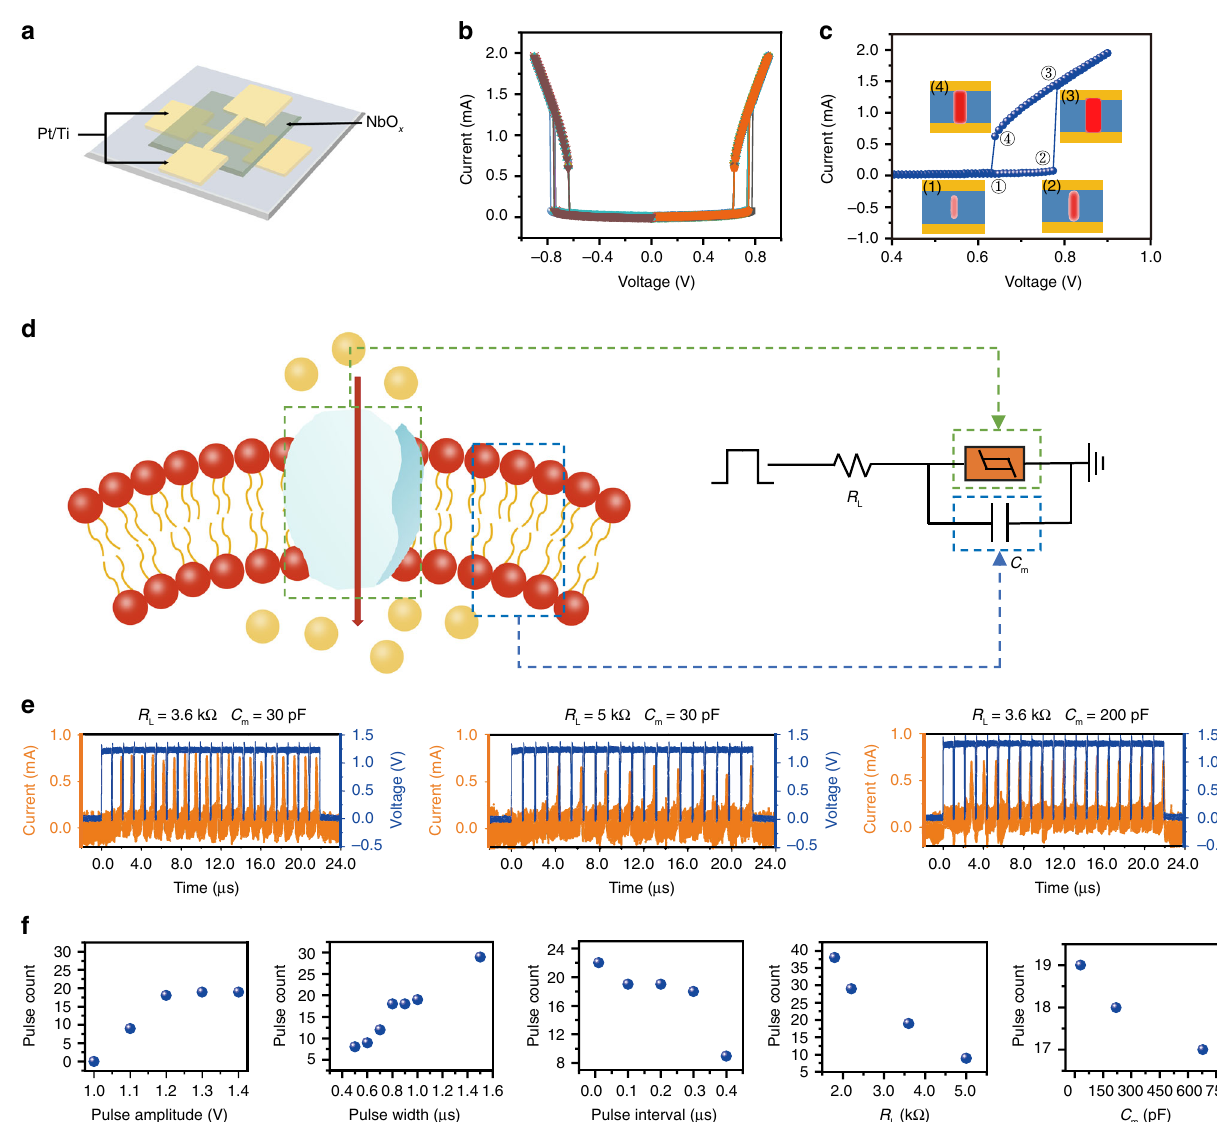
Fig. 2 Spiking neuron based on NbO x volatile memristors. a Schematic diagram of the memristive device, which consists of a NbO x layer sandwiched between two Pt/Ti electrodes. b Current-voltage characteristics of the device repeated for 10 cycles. c Schematic illustration of the mechanism responsible for threshold switching in the NbO x devices. d Illustration of an ion channel embedded in cell membrane of a biological neuron, with corresponding circuit based on NbO x devices for implementation of a spiking neuron. e Characterization of the LIF neuron under a continuous pulse train and the in fl uence of varying capacitance ( C m ) and resistance ( R L ). f The fi ring response of the spiking neuron under different input and circuit conditions. When changing the input parameters such as the pulse width, pulse interval and circuit parameters such as C m and R L , the fi ring pulse count has an obvious change with 20 input pulse